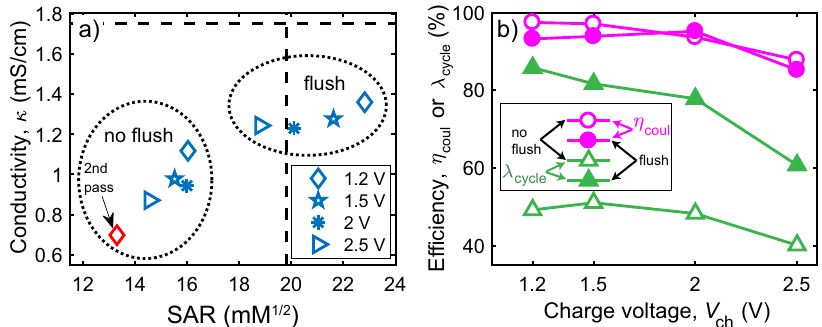
Fig. 5 Evaluation of extended voltage windowing and fl ushing on produced water quality in the S – P cell. a Measured product water SAR and conductivity. b Measured Coulombic ef fi ciency η coul and charge ef fi ciency λ cycle Þ = Fq dis , where F is the Faraday constant, and indicates the ratio of moles of ions removed to moles of electric charged stored in the electrodes (calculated from q dis ). The low charge ef fi ciencies of 40 – 50% in the no- fl ush experiments likely result from re-salinization of the desalted water present in the cell immediately after charging 73 . Overall, incorporating a